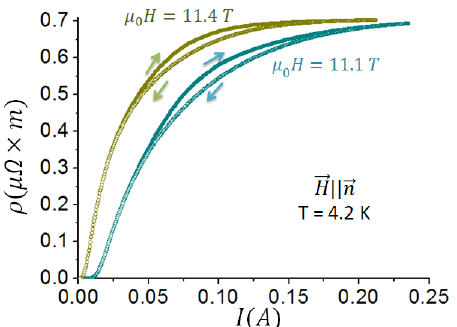
Fig. 3. RCC for the cold-rolled Nb-Ti tape. The field of 11.5 T lies in tape plane. Up to the threshold current value (point 1) the RCC is reversible. If the threshold value is exceeded, an abnormal hysteresis arises, so that the return branch of the characteristic lies below the forward one.